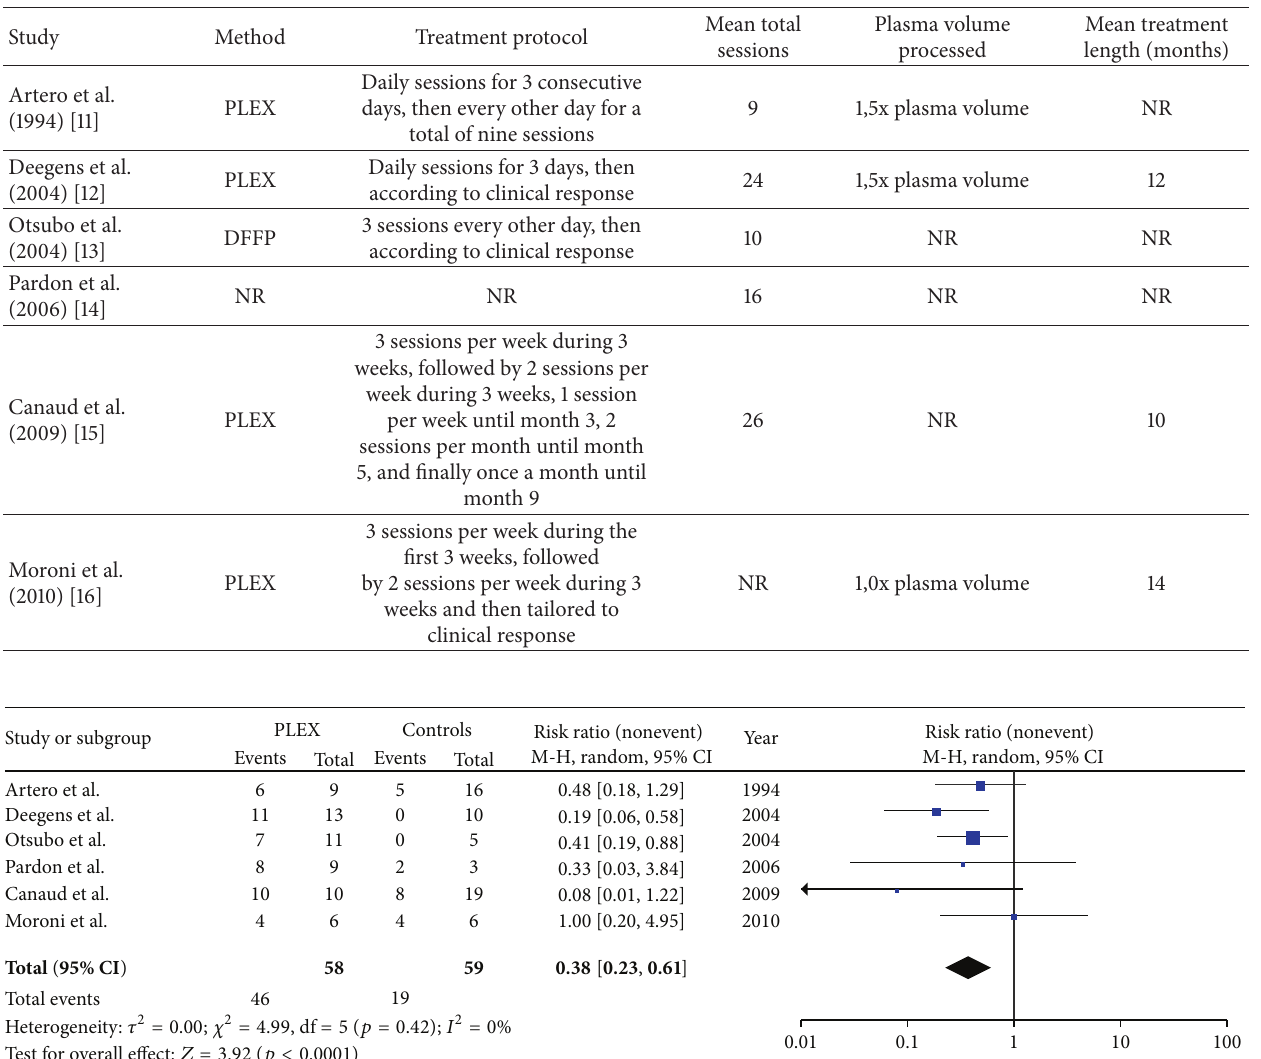
Table 2: Characteristics of treatment in included studies. DFFP: double filtration plasmapheresis; NR: not reported; PLEX: plasma exchange.